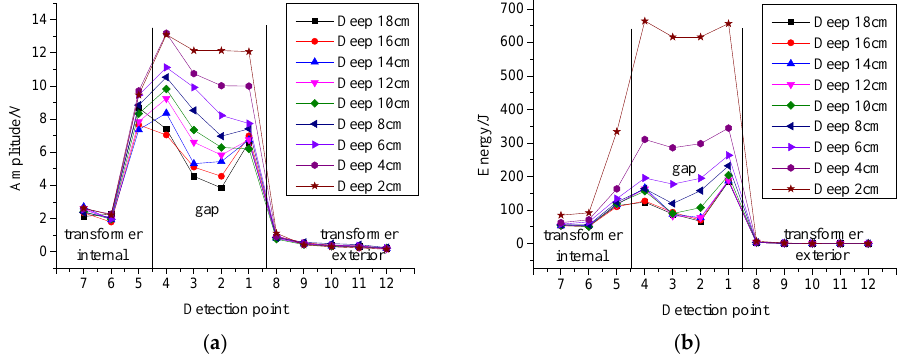
Figure 13. Distributions of PD electromagnetic signals in different depth gaps: ( a ) Amplitude distribution; ( b ) Cumulative energy distribution.